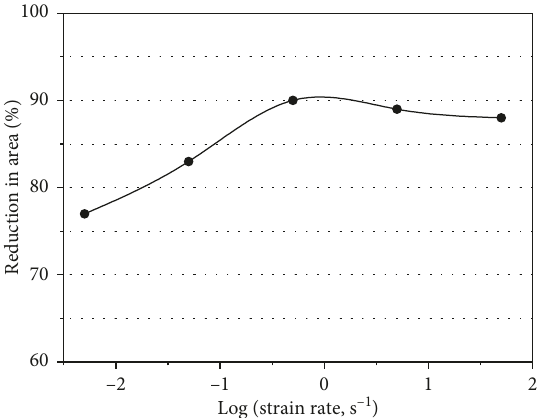
Figure 3: Dependence of reduction in area on the strain